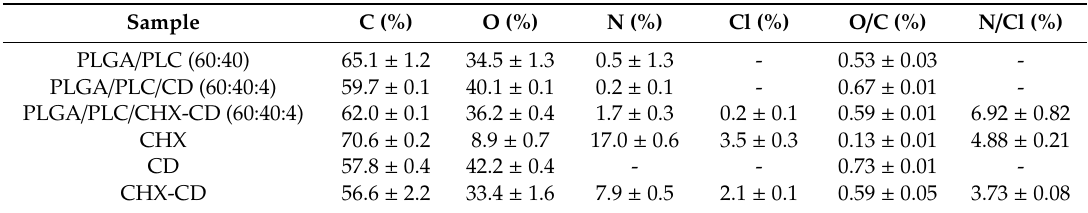
Table 2. Elemental composition (at %) measured by XPS on the PLGA / PLC (60:40) membrane, PLGA / PLC (60:40) membrane with CD (4%), PLGA / PLC (60:40) membrane with CHX-CD (4%) and CHX, CH, CHX-CD powder.